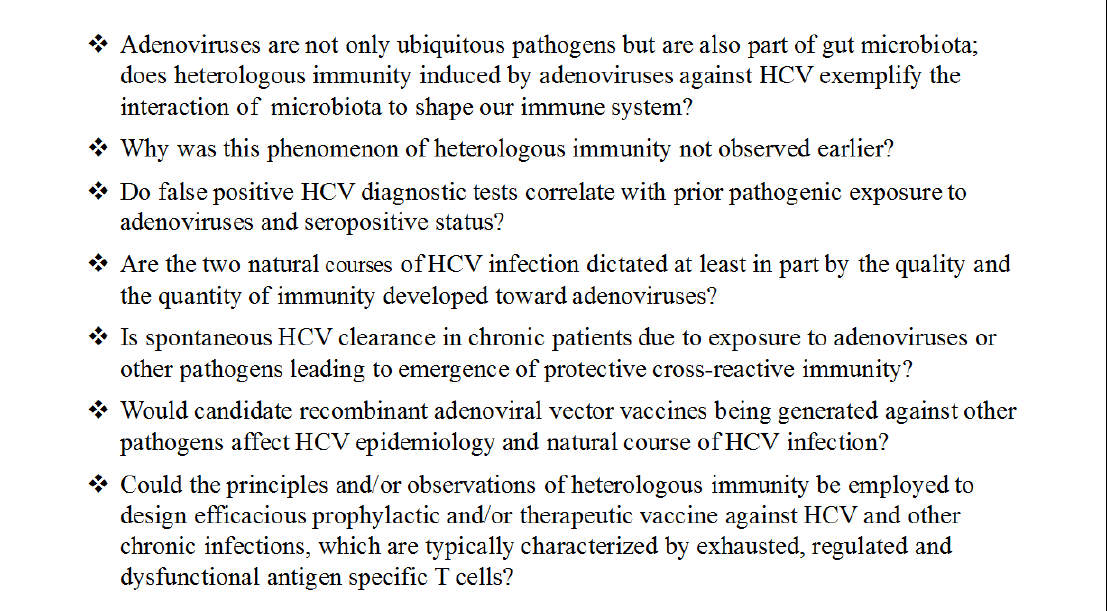
Figure 6. Diagnosis of hepatitis C virus by anti-HCV antibodies Enzyme Immunoassay or Chemiluminescence Immunoassay (EIA or CIA). Box 1. Future directions and implications of heterologous immunity on HCV.